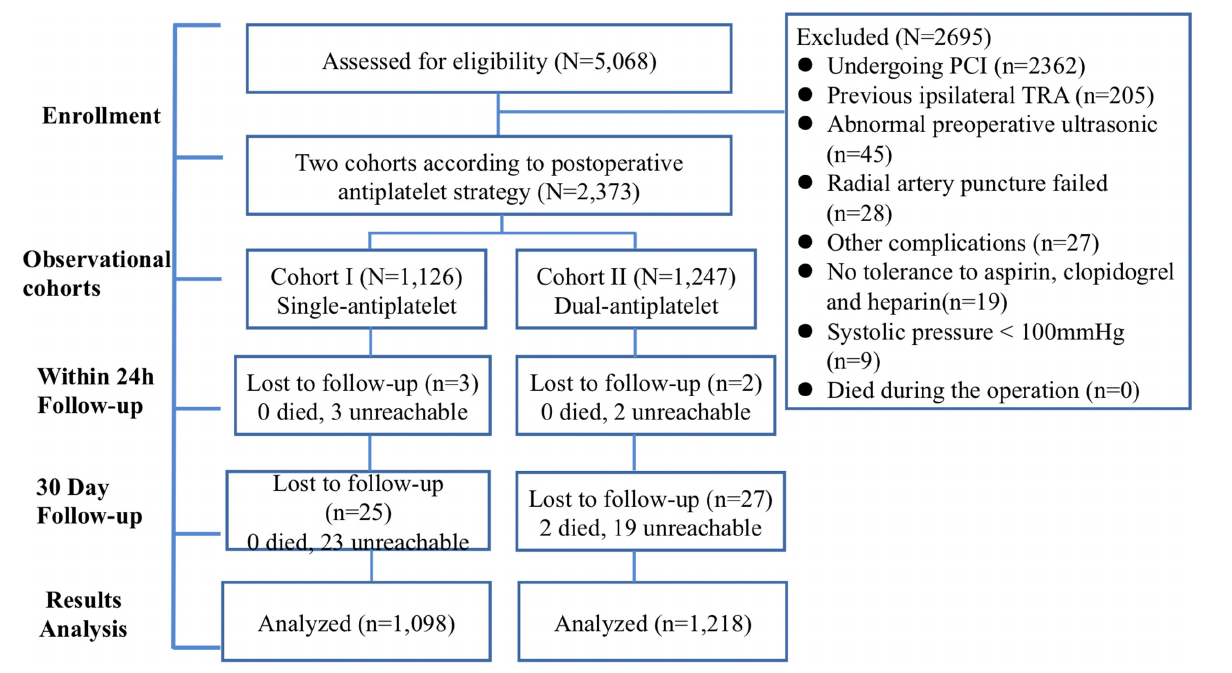
FIGURE 1 | Flowchart of study. PCI, percutaneous coronary intervention; TRA, transradial